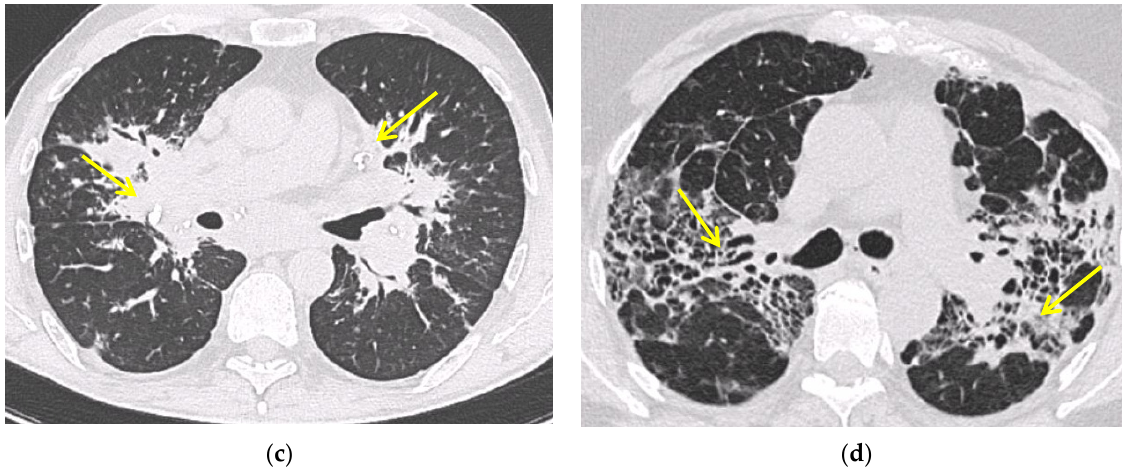
Figure 1. Irregularly marginated nodule surrounded by multiple small nodules (“Galaxy sign”, yellow narrow), this is typical of sarcoidosis ( a ); ground-glass-like increased attenuation resulting from diffuse micronodules randomly distributed (“Miliary sarcoidosis”) ( b ); enlarged and partially calcified (yellow narrows) bilateral hilar lymph nodes ( c ); fibrotic sarcoidosis with cystic changes and traction bronchiectases (yellow narrows) predominantly in the perihilar region and upper lobes. Nodular abnormalities are minimal/absent, but the appearance and the location of the fibrosis are very suggestive of the diagnosis of sarcoidosis ( d ).